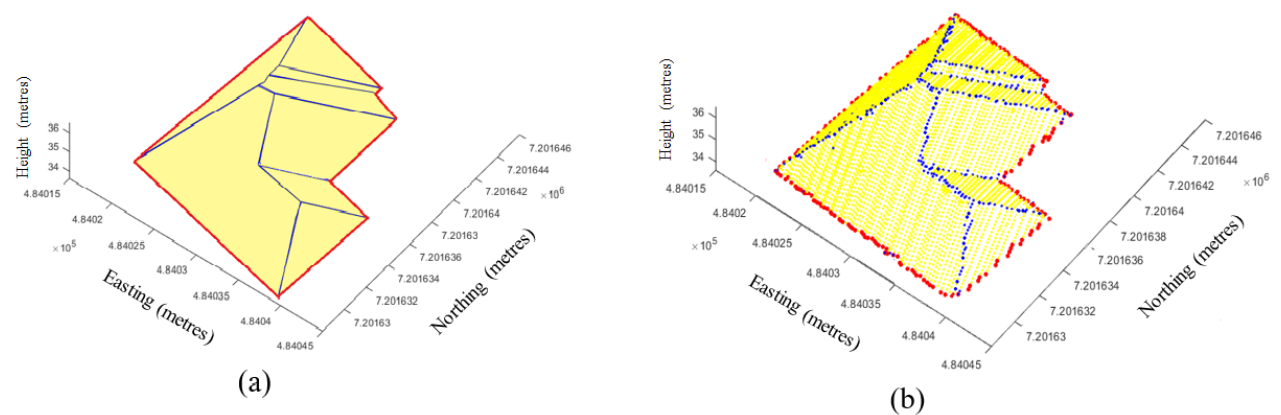
Figure 11. Linear (red), planar (green), and fold edge (blue) points using the fixed k -NN and the proposed variable neighbourhood: ( a ) k = 9, ( b ) k = 30, ( c ) k = 45, ( d ) k = 60, ( e ) k = 90, and ( f ) the proposed neighbourhood.